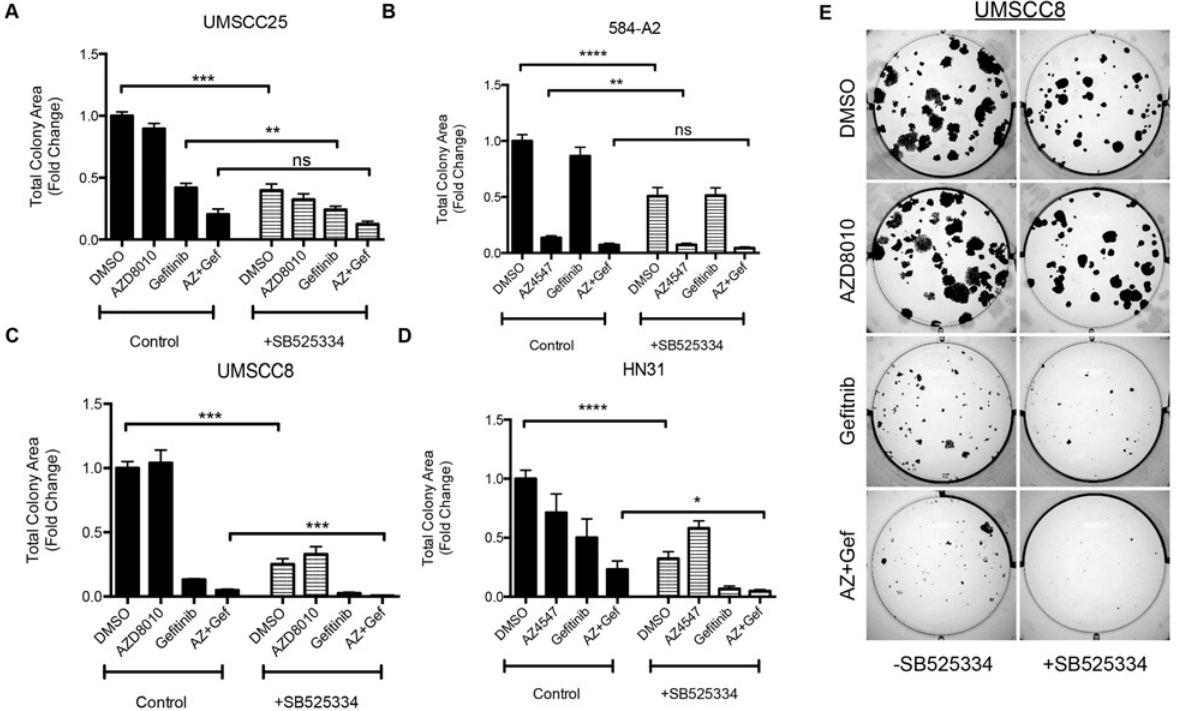
Fig 4. TGF- receptor inhibitors augment the effects of TKIs on colony growth formation. Clonogenic assays were performed where cells were treated with DMSO, 0.3 μ M AZD8010/AZD4547, 0.1 μ M gefitinib, or both in the presence or absence of a TGF- receptor I (TGFRI) small molecule inhibitor: SB525334 (1 μ M). After 2 weeks of incubation, colony growth was measured. This assay was performed in a panel of cell lines and is shown here for A. UMSCC25 B. 584-A2 C. UMSCC8 and D. HN31. E. Representative images of the experiment performed with UMSCC8 cells in C. * denotes a p-value < 0.05; ** denotes a p-value < 0.006; *** and **** denotes a p-value <